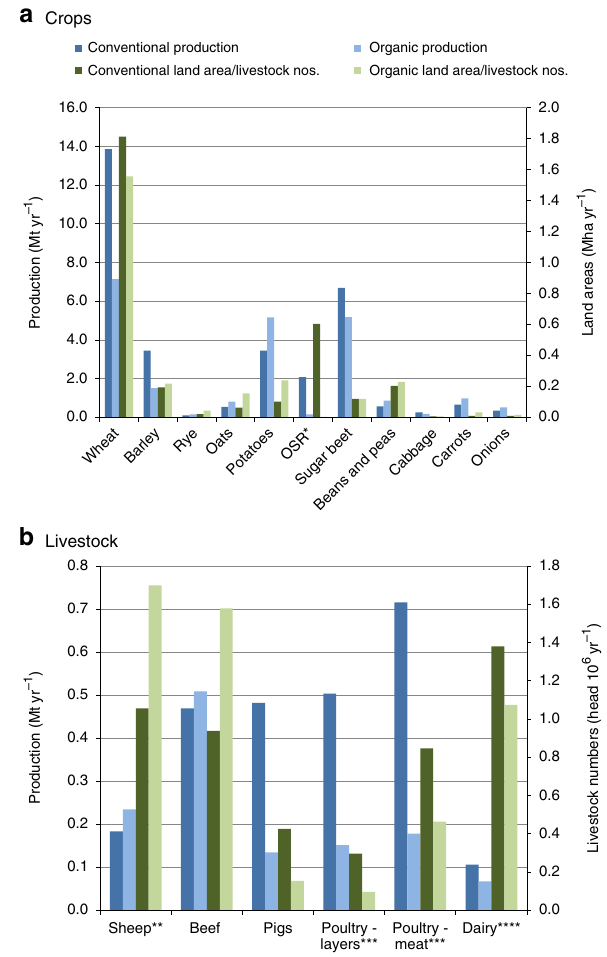
Fig. 1 Projected food production under conventional and organic farming methods. a Crop production and areas. *oilseed rape. b Livestock production and numbers. **sheep numbers × 10, ***poultry numbers × 100 , ****milk production in Mt × 10 5 . Conversion to 100% organic methods caused decreases in wheat, barley, oilseed rape, pigs, eggs, poultry